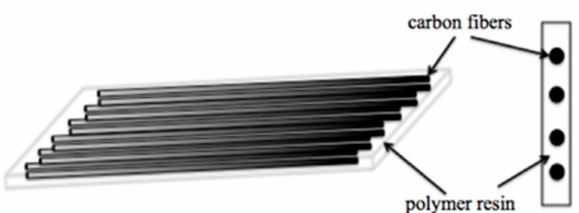
Figure 1. A typical structure of carbon fiber reinforced polymer (CFRP).